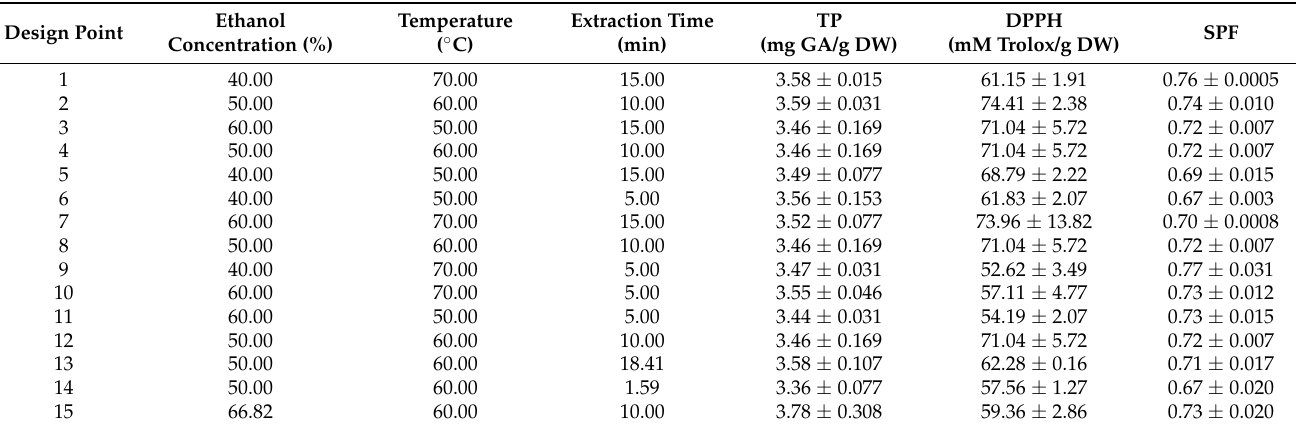
Table 1. Experimental values of TP, DPPH and SPF for apple extracts obtained by sonication and measured at design